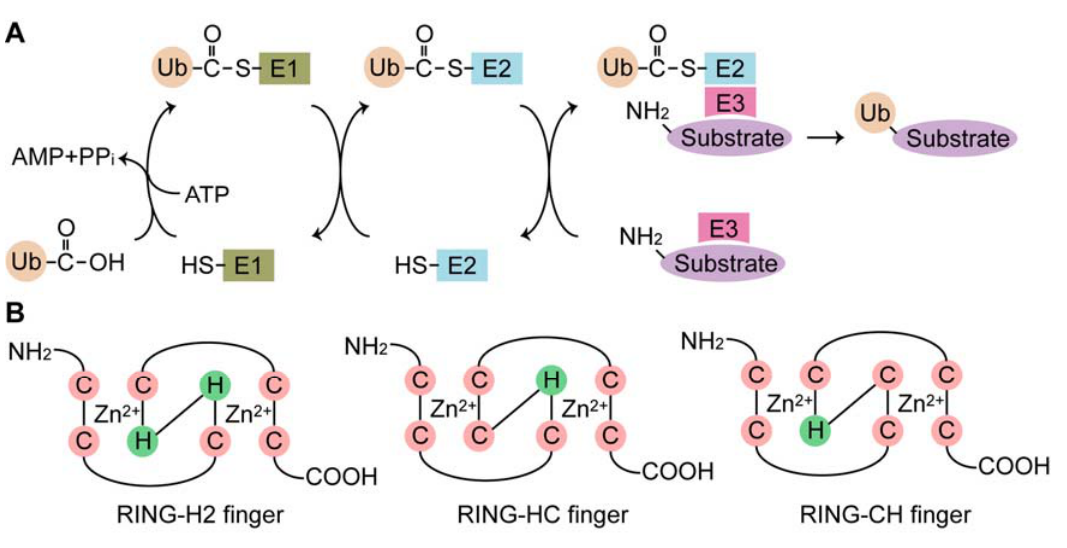
Figure 1. Schematic representations of the ubiquitination reaction and the RNF domain structures. ( A ) The biochemical steps in ubiquitination are illustrated. Ub is activated at its C-terminal glycine residue (Gly76) in an ATP-dependent manner by E1. In an ATP-hydrolyzing reaction, a Ub adenylate intermediate is formed, followed by the binding of Ub to a specific cysteine residue of E1. Ub is then transferred to an active site cysteine residue of E2, preserving the high energy thioester bond. The substrate is recognized by E3, which also recruits the E2–Ub complex. Finally, Ub is linked by its C-terminus in an isopeptide linkage to an ε -amino group of lysine residues on the substrate protein. ( B ) A simple comparison of the cross-brace arrangements of the RING-H2, RING-HC and RING-CH finger motifs. C and H indicate the conserved Zn 2+ -coordinating cysteine and histidine